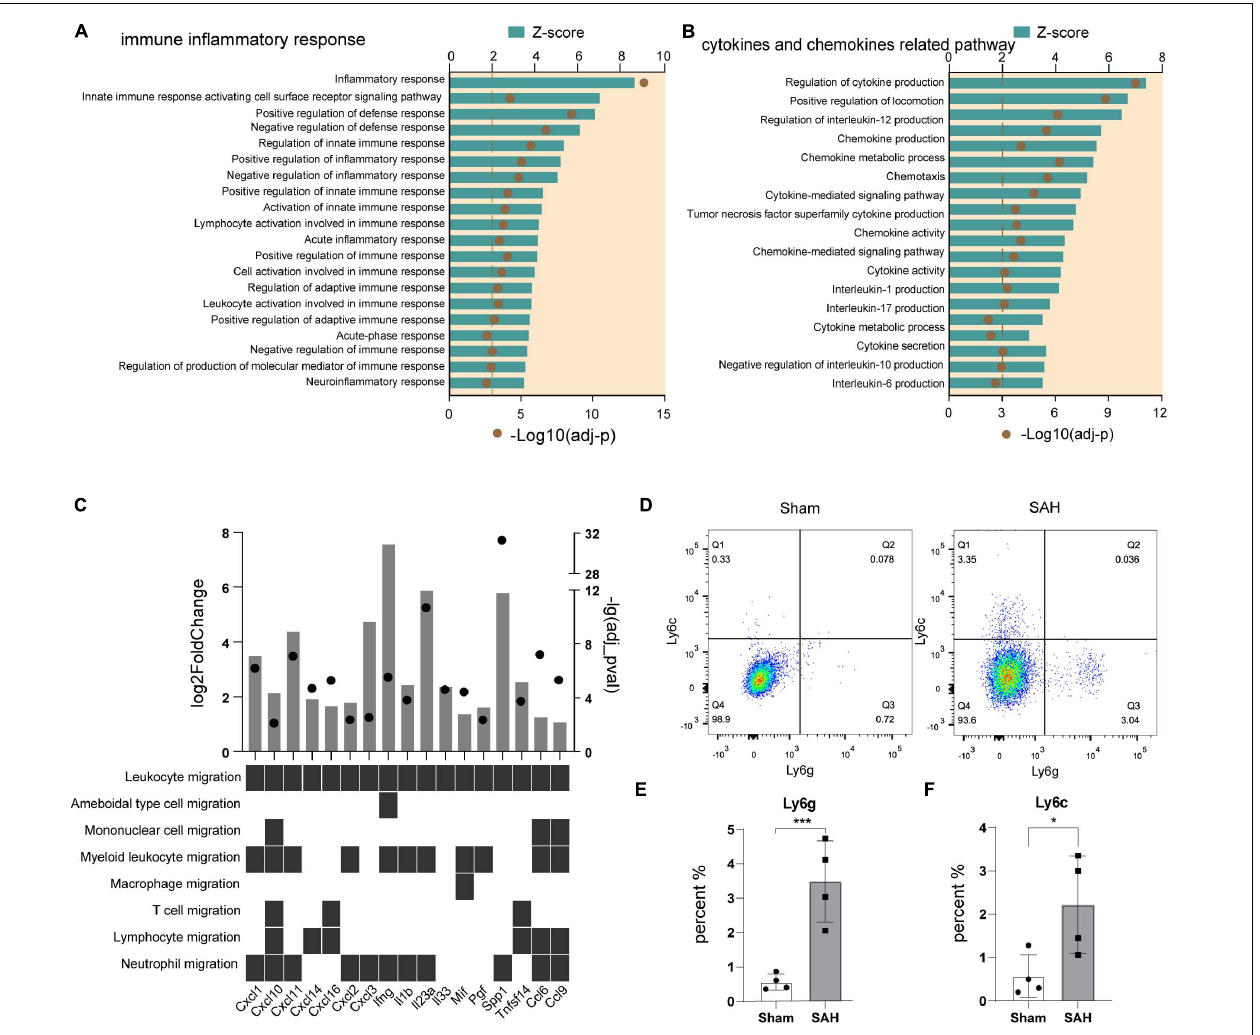
FIGURE 3 | Immune response and chemotaxis term were activated in post-SAH microglia. (A) GO enrichment analysis was performed by Metascape on all DEGs in sham and SAH microglia. Shown are the z -scores of biological functions on inflammatory and immune response-related pathways. (B) Shown are the z -scores of biological functions on cytokine and chemokine-related pathways. (C) Expression profiles of DEGs (fold change > 2, adj_pval < 0.01) in SAH microglia related to leukocyte recruitment pathways. (D–F) Flow cytometric analysis showed that the number of Ly6c+ and Ly6g+ cells increased after SAH, n = 4 per mice group. DEG, differentially expressed gene. * P < 0.05, *** P <